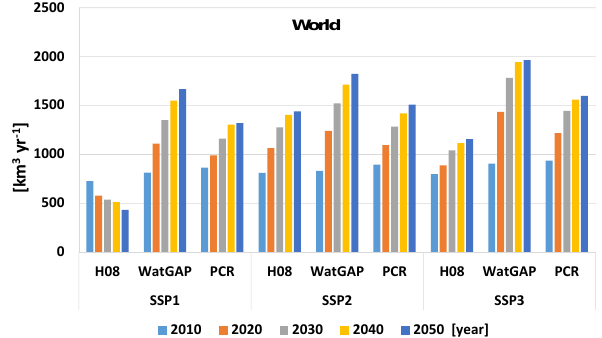
Figure 2. Ensemble of three global industrial water withdrawal projections calculated by the global water models H08, Water- GAP (WatGAP), and PCR-GLOBWB (PCR) for the years 2010, 2020, 2030, 2040, and 2050, respectively, under three SSP scenar- ios (SSP1, SSP2, and